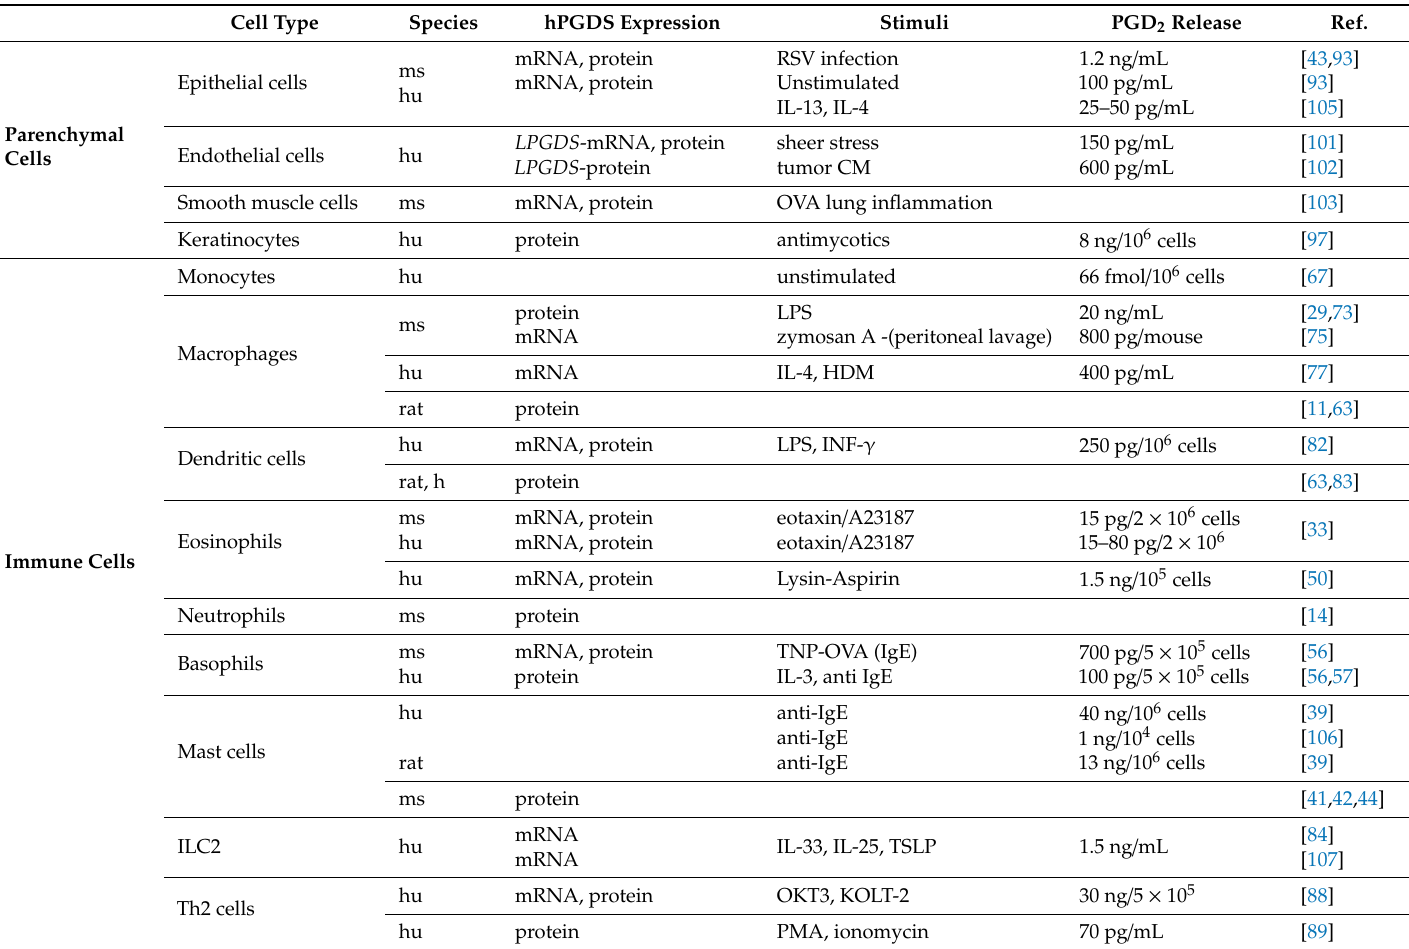
Table 1. Cell type specific hPGDS expression and reported PGD 2